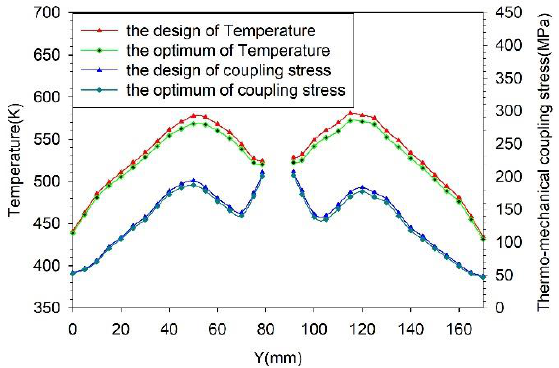
Figure 19. Comparison of thermo-structure coupling load in the radial direction Y of the cylindrical head.